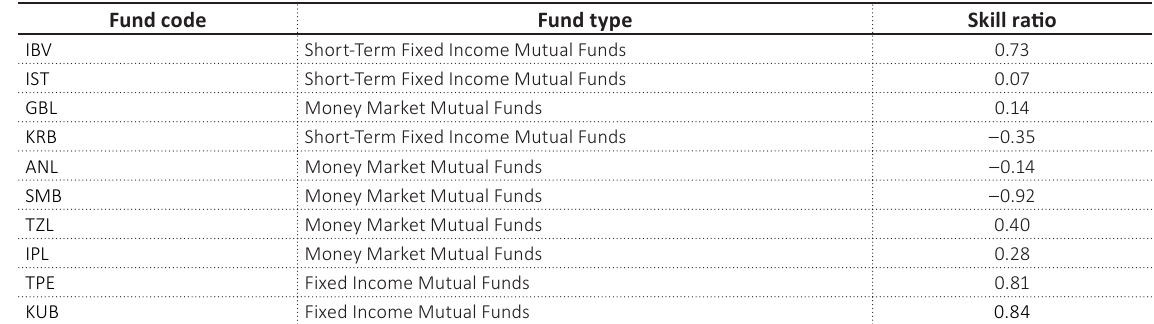
Table 7. Skill ratios of persistent mutual funds